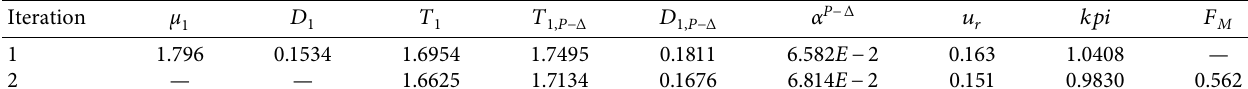
Figure 21: Building B3 under BIGBEAR record with diferent distributions of reinforcements: (a) comparison between NRHA and interstorey drifts limit, (b) NRHA fexural moment demands and MMPD fexural capacities of 30cm wall, (c) NRHA fexural moment demands and MMPD fexural capacities of 20cm wall, (d) NRHA/approximated MMPD shear demands, and (e) NRHA/approximated MMPD torsional demands. Table 16: Design summary of B2 for frst and second iteration under BORREGO